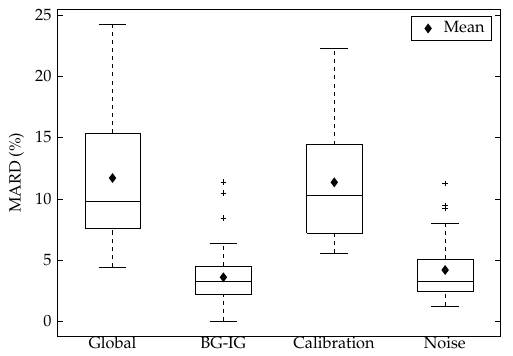
Figure 5. Boxplots of the mean absolute relative difference